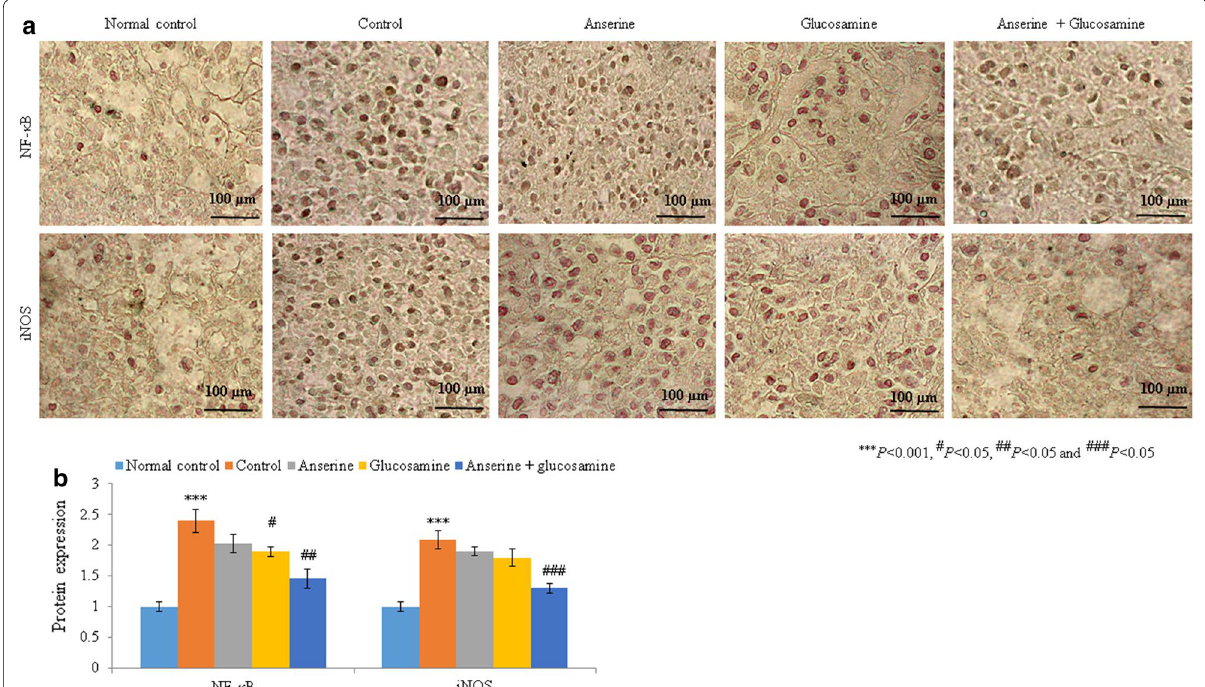
Fig. 2 Anserine plus glucosamine supplementation reduced the protein levels of NF-κB and iNOS in synovial tissue. a Immunohistochemical analysis of NF-κB and iNOS. b Analysis of the protein levels in a . Scale bar is 100